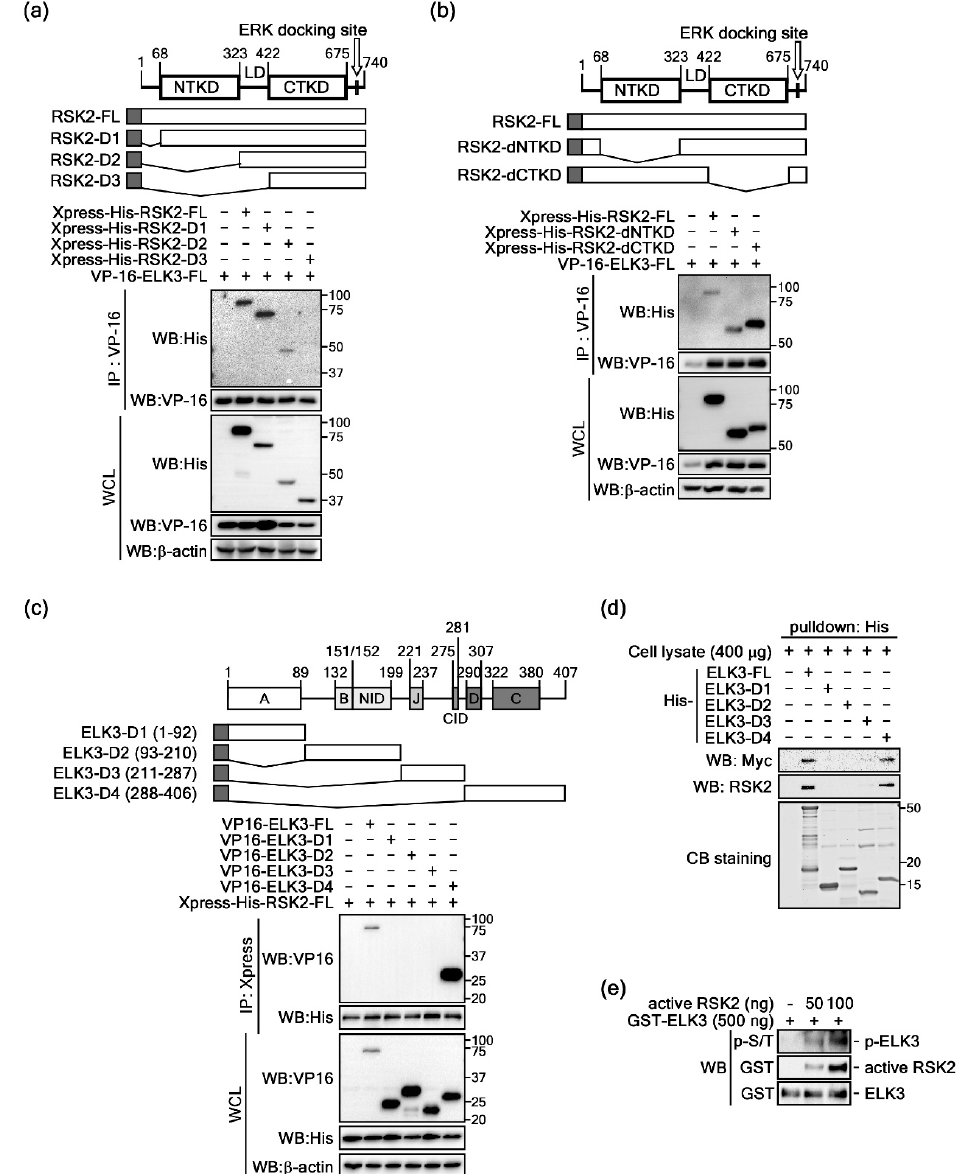
Figure 2. Determination of the binding domain for the RSK2-ELK3 interaction. ( a ) Representative images of immunoprecipitation results for RSK2 serial deletion mutants with full-length ELK3. The expression constructs were co-expressed in HEK293T cells as indicated, and ELK3 was immunoprecipitated with a VP-16 tag specific antibody. Binding of the RSK2 serial deletion mutants was visualized by western blotting using His-tag specific antibodies. WCL, whole cell lysate; IP, immunoprecipitation. ( b ) Representative IP images of RSK2 kinase deletion mutants with full-length ELK3. RSK2 kinase deletion mutants were co-expressed in HEK293T cells as indicated and ELK3 was immunoprecipitated with VP-16 tag specific antibody. The binding of RSK2 kinase deletion mutants was visualized by western blotting using His-tag specific antibody. WCL, whole cell lysate; IP, immunoprecipitation. ( c ) Representative IP images of ELK3 serial deletion mutants with full-length RSK2. The expression constructs were co-expressed in HEK293T cells as indicated, and RSK2 was immunoprecipitated with an Xpress tag specific antibody. The binding of ELK3 serial deletion mutants was visualized by western blotting using VP-16 tag specific antibody. WCL, whole cell lysate;